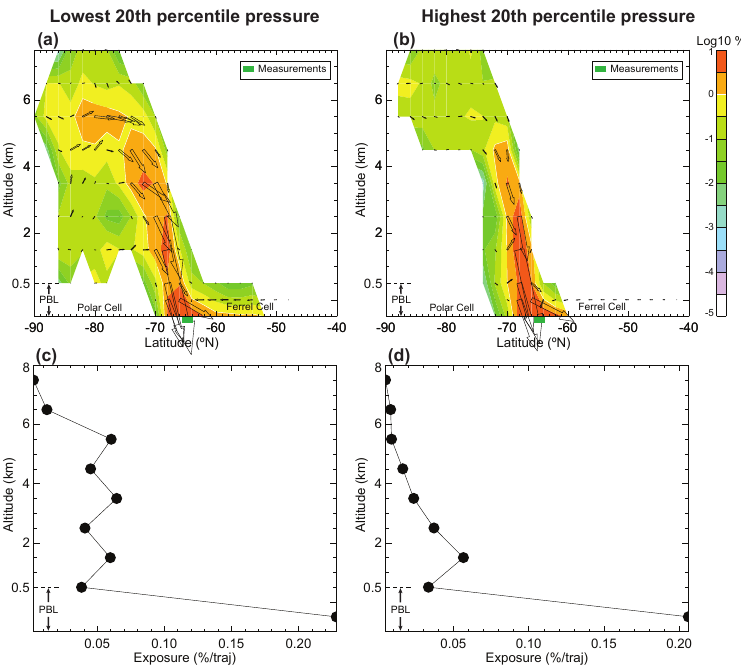
Figure 6. Analysis of 5-day back trajectories released at 10m height from the marked (green) measurement location every hour of sea-ice voyage for the two different pressure scenarios: the lowest 20th percentile of pressures ( a and c ) and the highest 20th percentile of pressures ( b and d ). Panels (a) and (b) are similar to Fig. 3, but show the frequency (i.e. number of times a trajectory passes through a given grid box) component, colours plotted in log scale. (c) and (d) show the exposure of the trajectories to each altitude interval. This is defined as the mean percentage of time trajectories spent in each 1km layer of the atmosphere up to 8km. Note again the expansion of the PBL in all